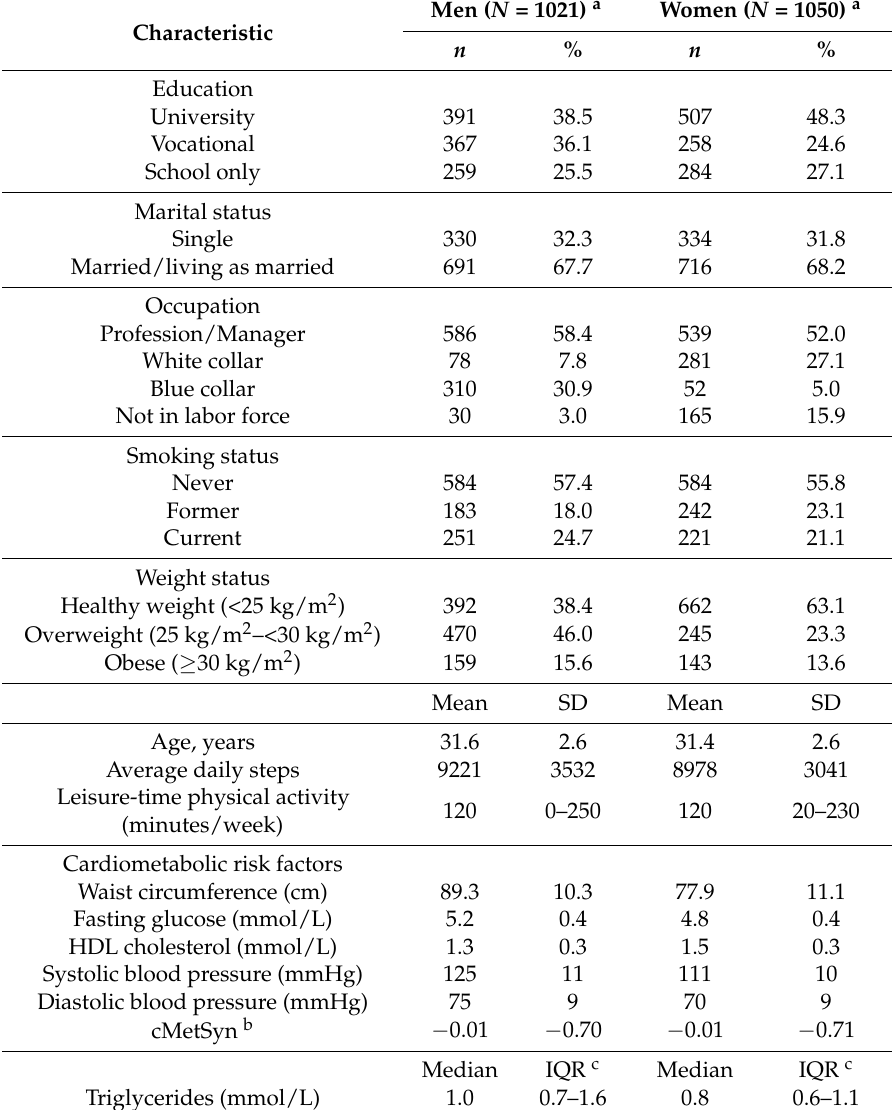
Table 1. Sociodemographic, lifestyle and cardiometabolic characteristics of participants from the Childhood Determinants of Adult Health study, aged 26–36 years